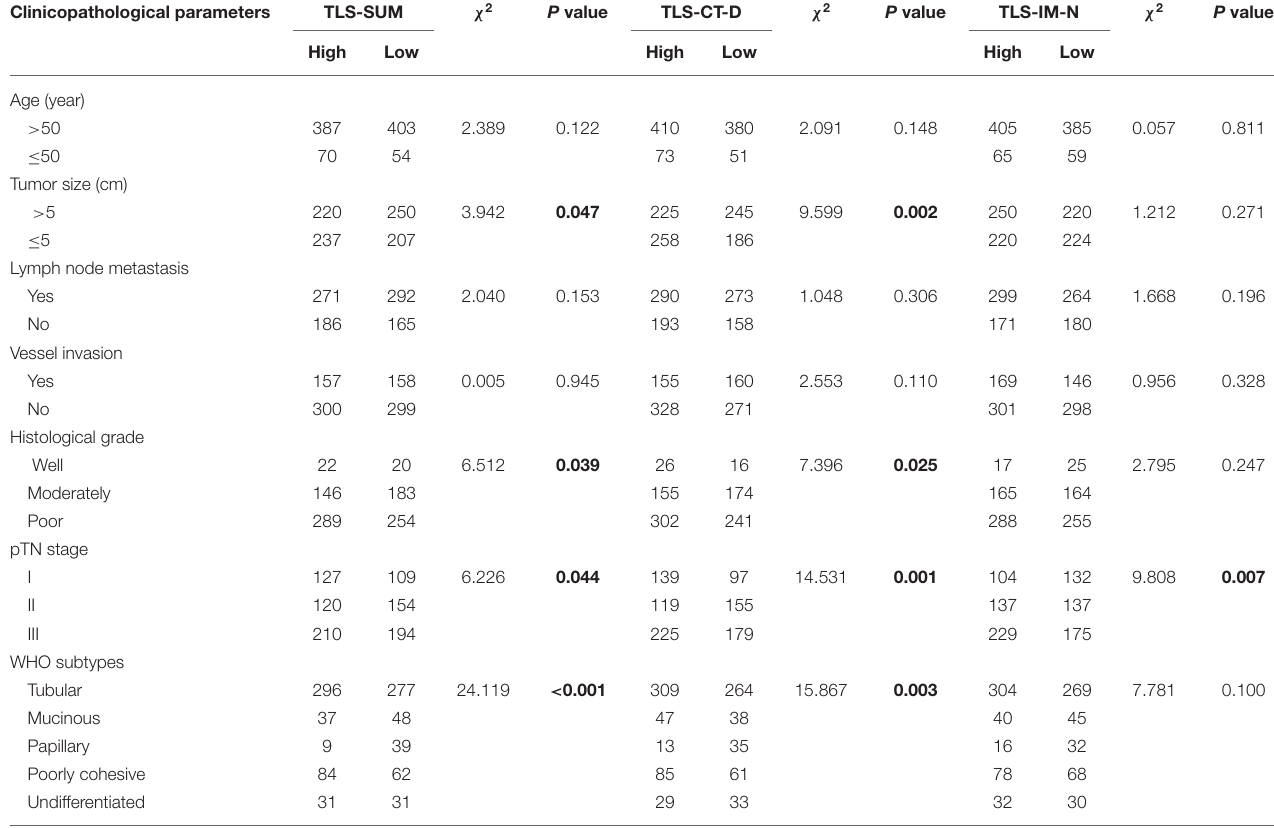
TABLE 3 | Relationship between tertiary lymphoid structure (TLS) and clinicopathological parameters. Clinicopathological